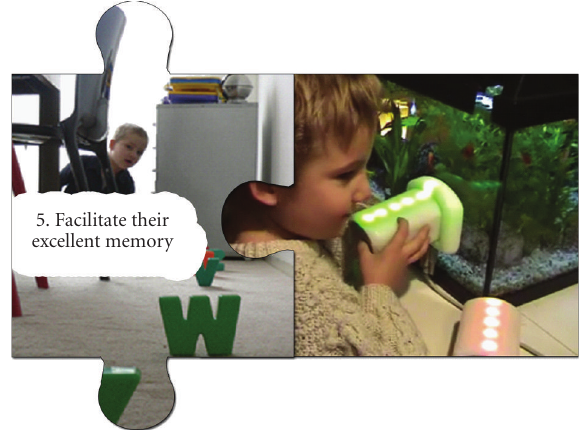
Figure 9: An excellent memory: (a) Beer playing with his alphabet letters on the floor; he knows its sequence by heart, so he can lay the alphabet from “A” to “Z” and from “Z” to “A.” (b) Beer plays with LINKX; he remembered the green lights belong to “fishbowl” and the red ones to “window.”